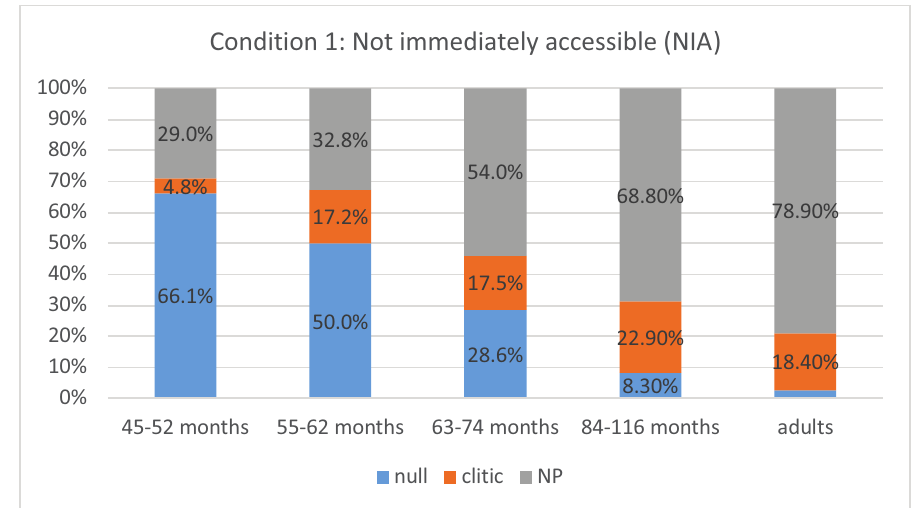
Figure 3: Distribution of null, clitic and NP objects in Condition 1 (NIA).